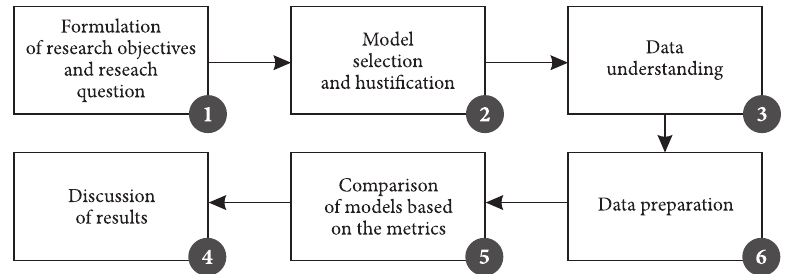
Figure 1. Six primary phases of the research